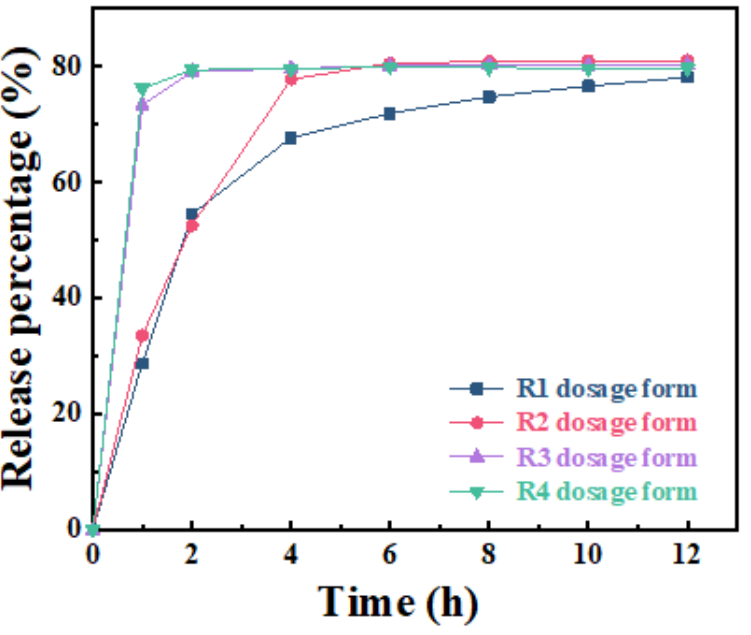
Molecules 2022 , 27 , x FOR PEER REVIEW Figure 5. Cumulative drug release rate for R1, R2, R3 and R4 dosage forms. Figure 5. Cumulative drug release rate for R1, R2, R3 and R4 dosage forms.